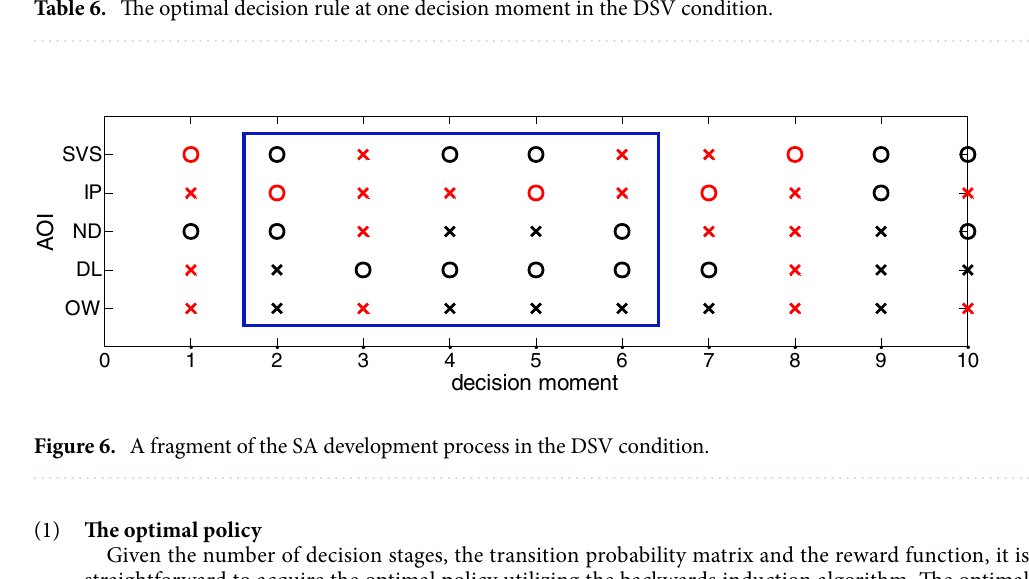
straightforward to acquire the optimal policy utilizing the backwards induction algorithm. The optimal policy in each condition is a matrix with a size of 32 ⨯ 960. Each column of the optimal policy matrix rep- resents an optimal decision rule at one decision moment and optimal decision rules at different decision moments are the same.